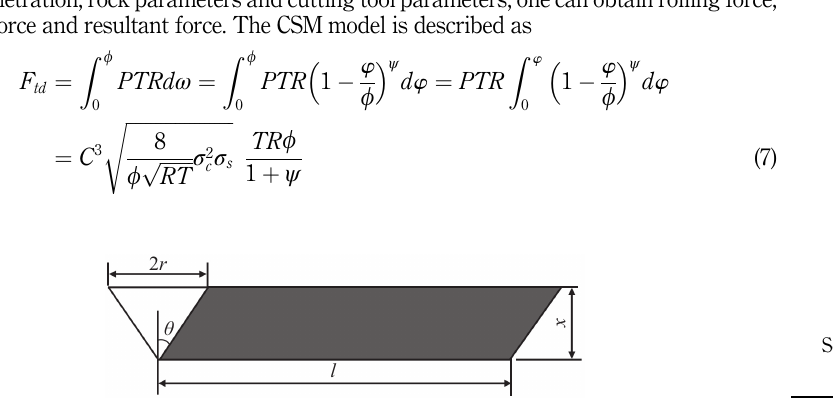
Figure 3. Schematic diagram of